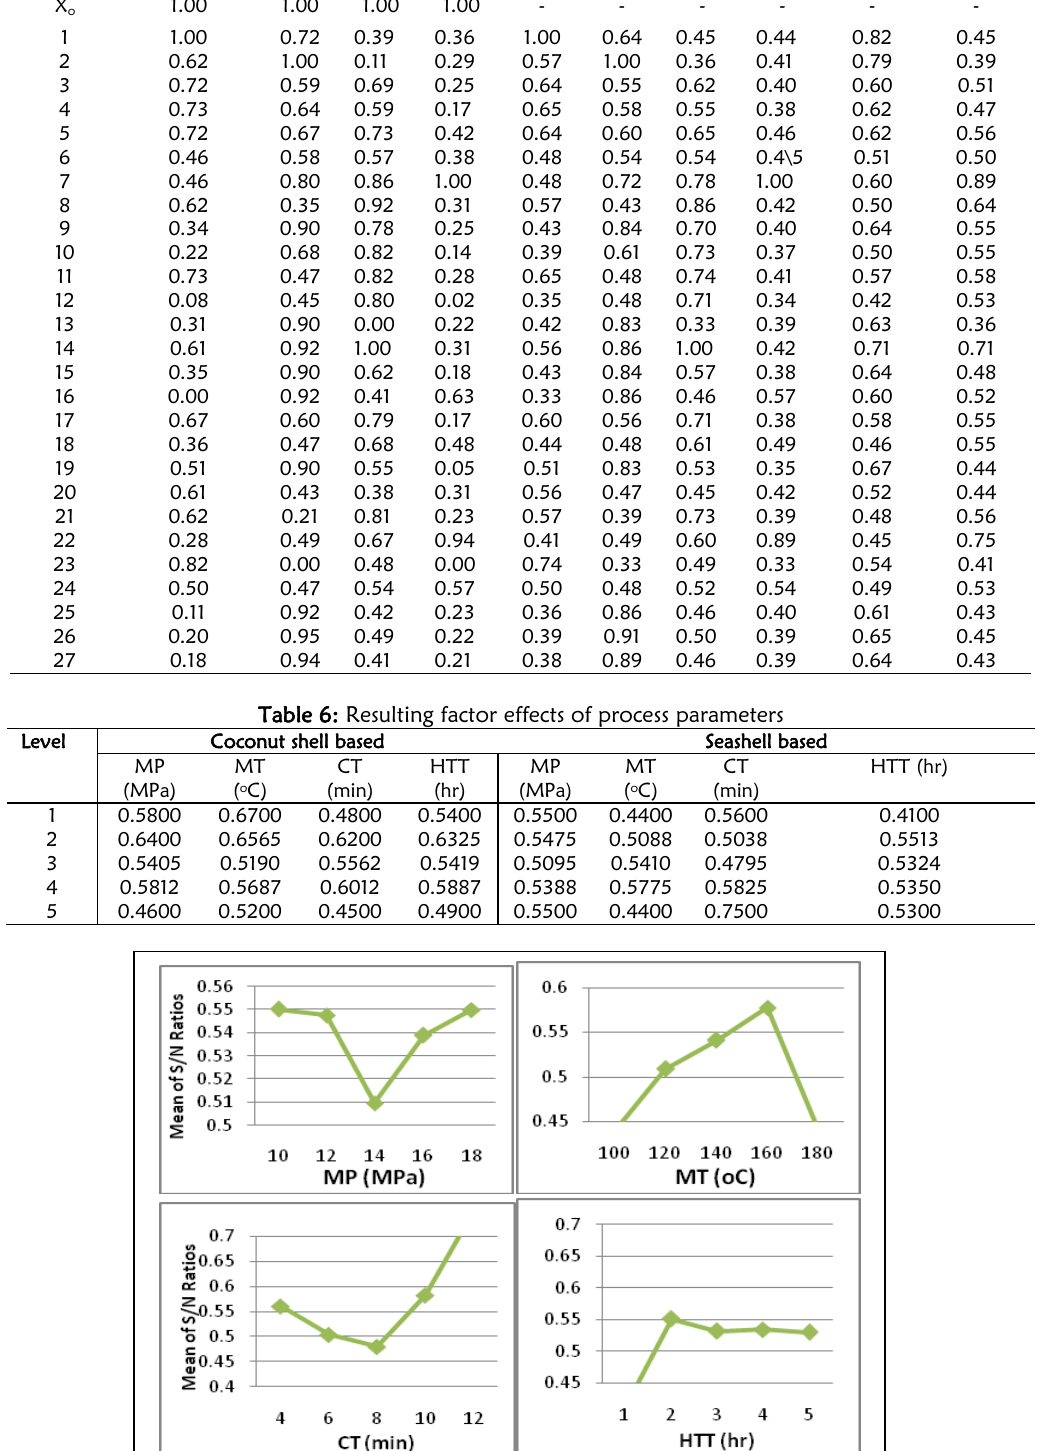
Figure 2: Main effect plots for coconut shell based